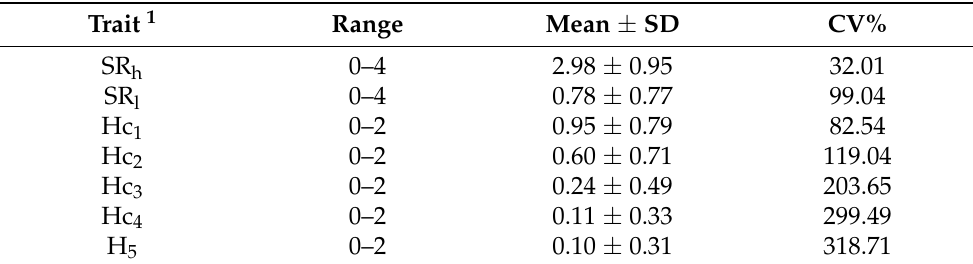
Table 5. Descriptive statistics for the 20,000 individuals sampled with genotypic records used for